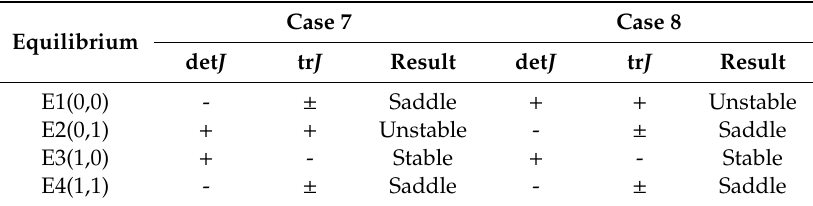
Table 8. Proposition 3: Analysis of local stability of equilibrium.